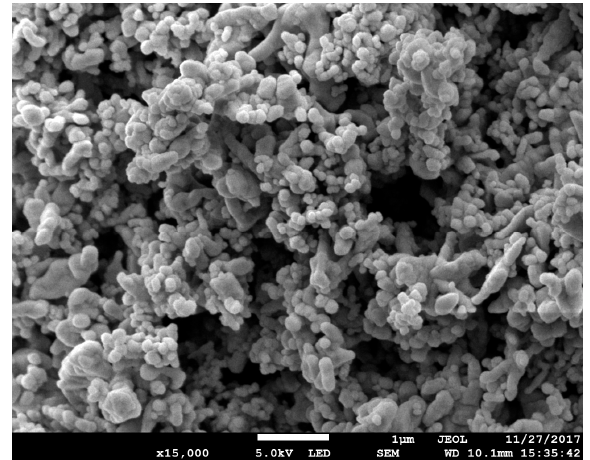
Figure 4. FESEM image for dry CNC-CuO nanoparticle powder.